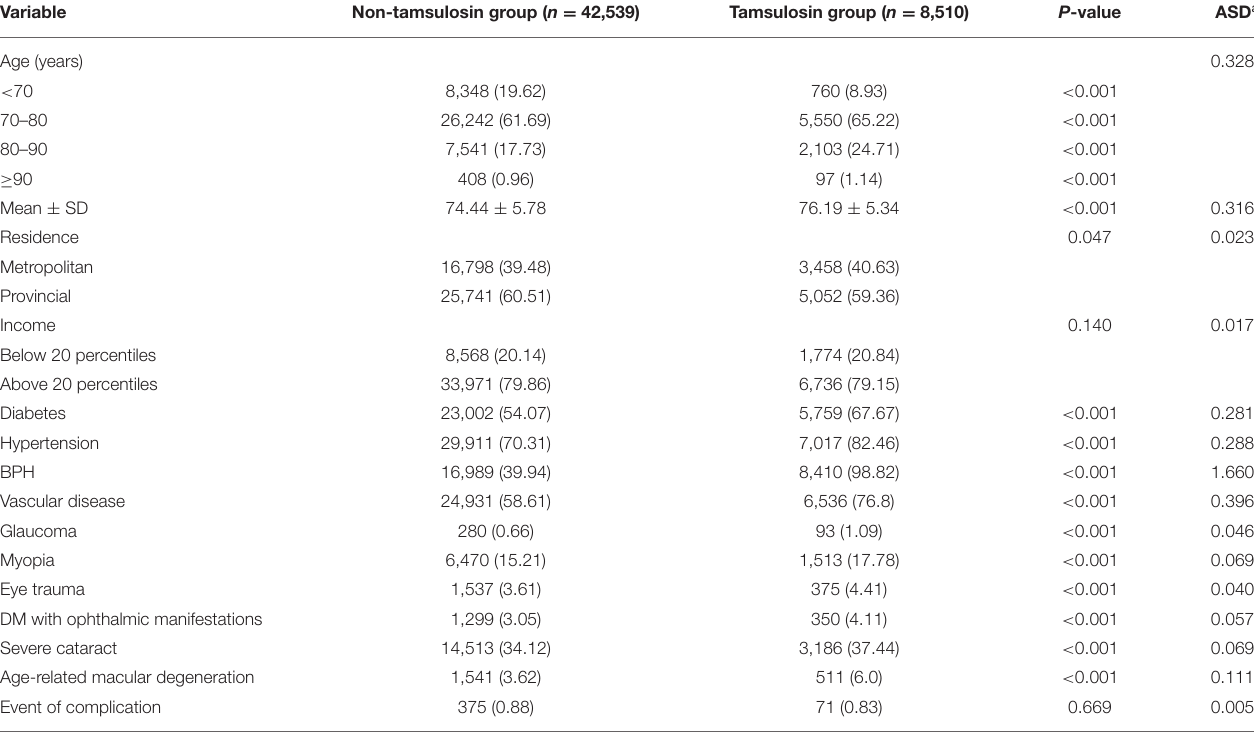
TABLE 1 | Baseline characteristics of subjects who underwent cataract surgery according to tamsulosin use in the Korean elderly population. Variable